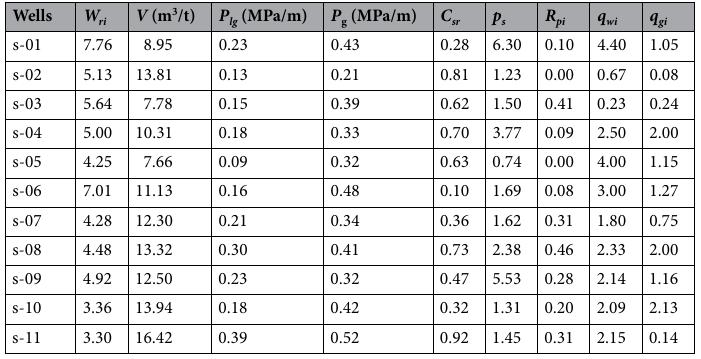
Table 4. List of evaluation parameters of 11 low production wells.